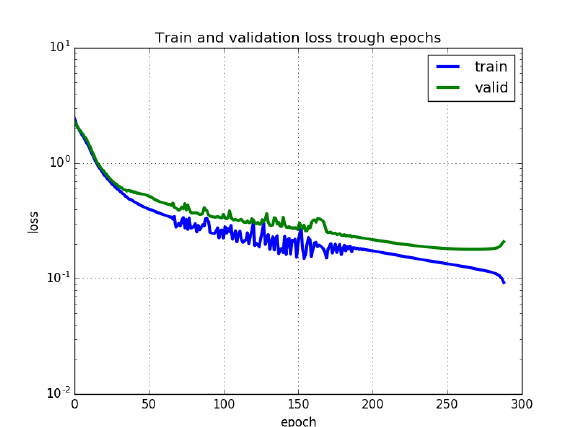
Figure 5. Convergence behavior of the CNN-RSL loss function (average over 10 folds of cross-validation on the KSC dataset).